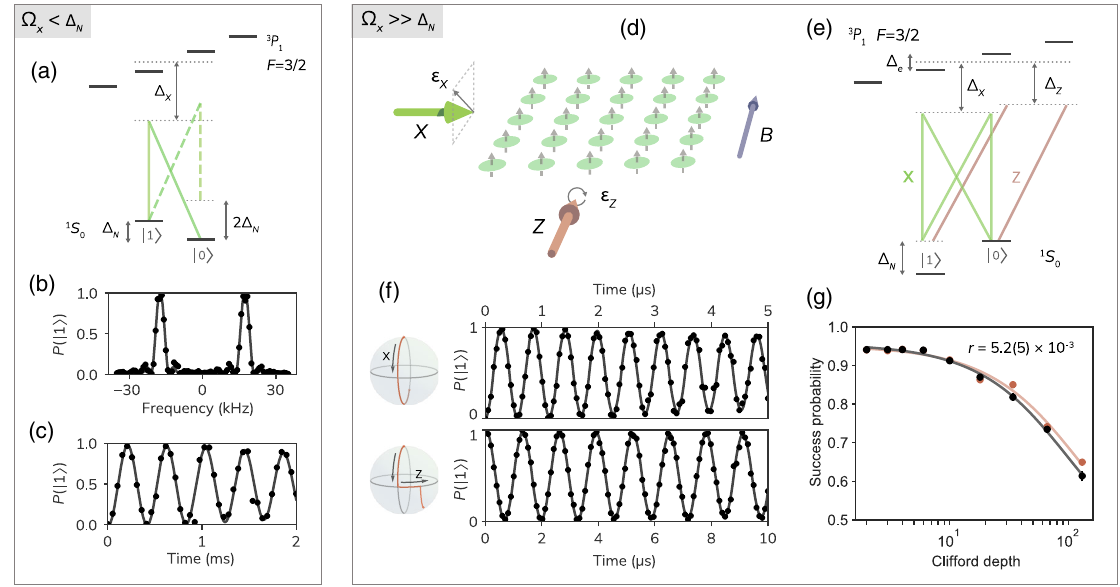
FIG. 3. Nuclear-spin control. (a) The Raman level diagram corresponding to the weak-drive regime. Two copropagating beams drive Raman transitions between the nuclear-spin states. The two beams have variable relative frequency, one with π polarization and the other with polarization normal to the atom plane (both σ and σ − polarizations). The rotations are performed through two excited states þ j F 0 ¼ 3 = 2 ; m F 0 ¼ (cid:3) 1 = 2 i but in the weak-driving regime one of these Raman transitions (dashed lines) is far off resonance compared to Ω and effectively does not contribute. The detuning from the F 0 ¼ 1 = 2 states is much larger than Δ and these states do not X X significantly affect the dynamics. (b) As we sweep the detuning between the Raman beams, the resonances corresponding to the two Raman pathways become visible. (c) Fixing the frequency to the left resonance, we drive Rabi oscillations at the kilohertz scale. The plotted probabilities of detecting the j 1 i state are normalized by the measured atom survival probability for the experiments in the absence of blow-away, which is 96.5(2)% for both (b) and (c); see Appendix C. (d) In the strong-driving regime, a single X beam with linear polarization ϵ tilted out of the atom plane drives two Raman transitions between the spin states. A second beam, Z , splits the x nuclear-spin states and drives oscillations around the Z axis. A small magnetic field B splits the nuclear-spin states by 1.25 kHz. = ð 2 π Þ ≃ − 180 MHz and Δ = ð 2 π Þ ¼ − 164 MHz, while the excited (e) Level diagram for X and Z beams. The beam detunings are Δ X Z = ð 2 π Þ ≃ 2 MHz. (f) The top panel shows X Rabi oscillations at 1.77 MHz. In the bottom panel, we state splittings are much smaller, Δ e measure Z oscillations at 0.77 MHz with a Ramsey-type sequence, where the Z beam is turned on for variable time between two X ð π = 2 Þ pulses. The survival probability for these experiments without blow-away is 96.3(1)%. The accompanying Bloch spheres show example trajectories for the two types of experiments. (g) Clifford randomized benchmarking using Clifford gates compiled of X ð π = 2 Þ and Z ð π = 2 Þ . The target output state is randomized between j 0 i and j 1 i . The black circles show the measured probabilities of obtaining the target state at a given Clifford gate depth. At each depth, we run 40 different sets of randomized experiments. The error bars are given by the standard deviation over the 40 sets of experiments. The extracted average gate infidelity per Clifford gate is 5 . 2 ð 5 Þ × 10 − 3 . The red circles show the simulated success probabilities using the estimated scattering error rates of the X and Z beams and shot-to-shot fractional intensity noise of 1%, with 3% fractional intensity noise from experiment to experiment (Appendix